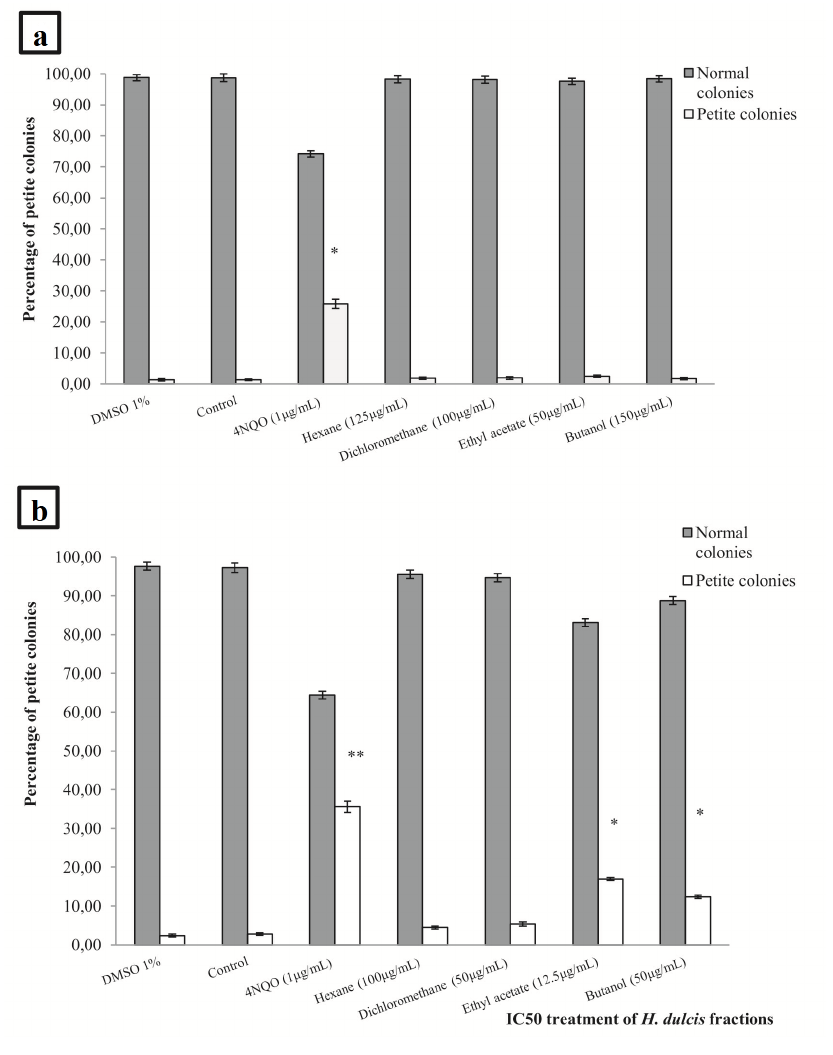
Figure 3. Petite colonies percentage after the treatment of H. dulcis extract fractions on S. cerevisiae strains, FF18733 (a) CD138 (b). Evaluation performed during 24 hours of incubation with fractions of H. dulcis ethanolic extract and controls *( p< 0.05) ** ( p < 0.01) compared to